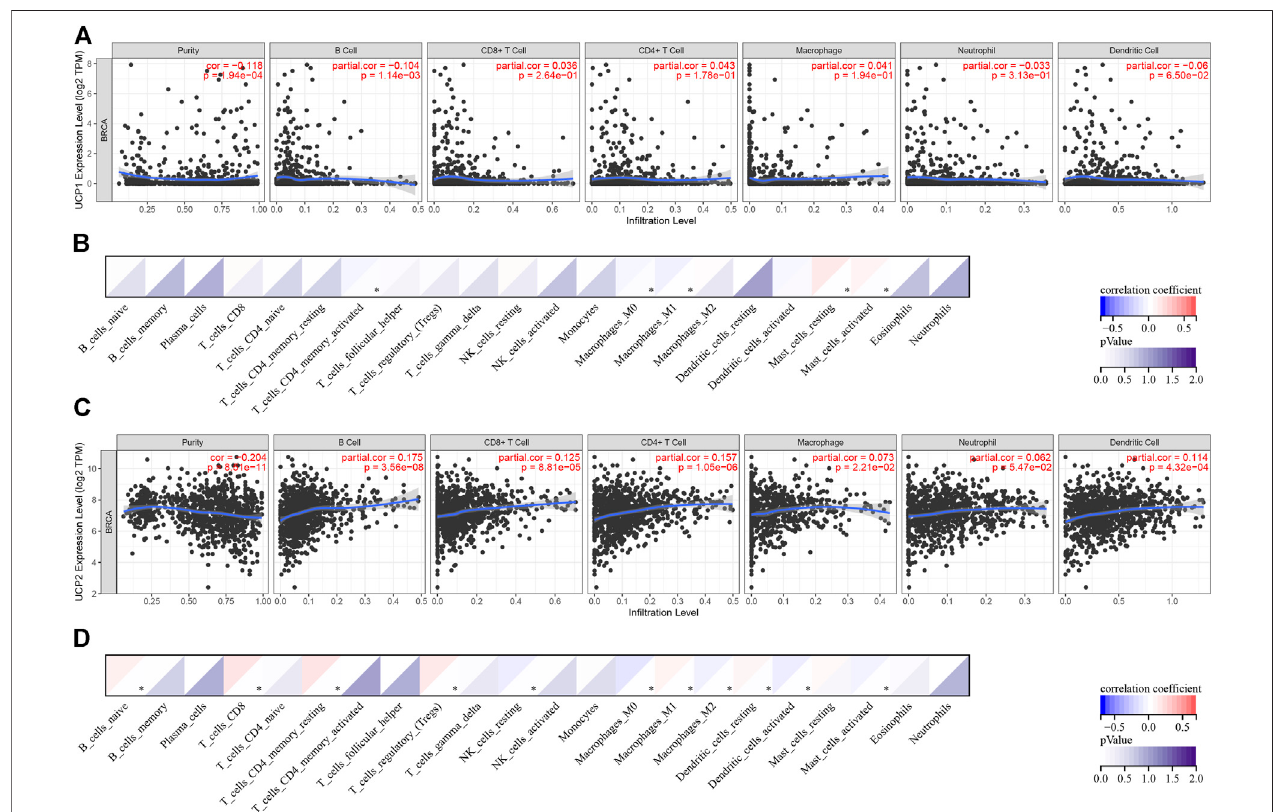
FIGURE 5 | Correlation analysis between UCPs and immune status. (A,B) Correlation analysis between UCP1 and immune cell types by (A) TIMER and (B) CIBERSORT. (C,D) CorrelationanalysisbetweenUCP2andimmunecelltypesby (C) TIMERand (D) CIBERSORT.CorrelationwasevaluatedbySpearman ’ scorrelation analysis. * p <